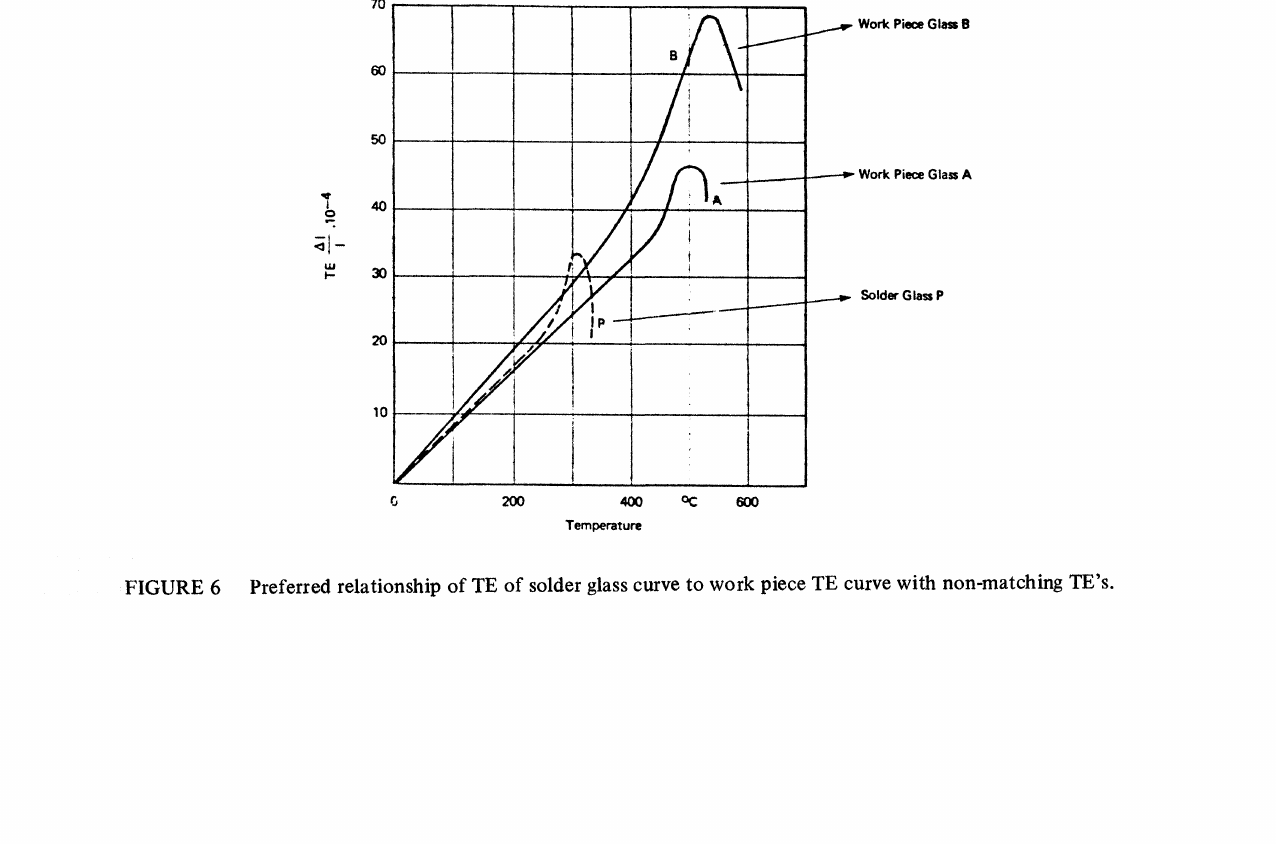
Preferred relationship of TE of solder glass curve to work piece TE curve with non-matching